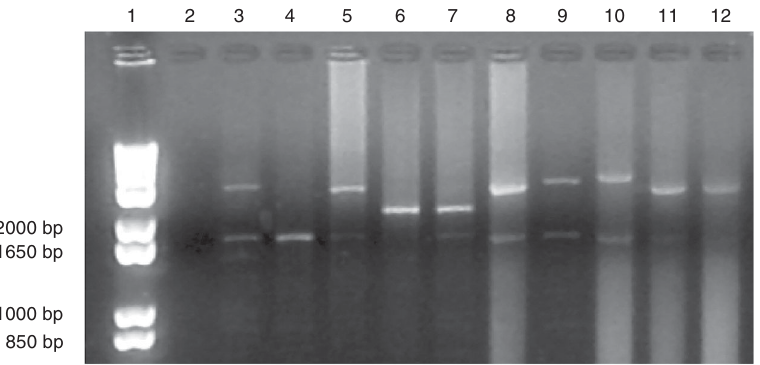
Figure 1. Amplified MUC-1 polymorphic fragments on 1.2% agarose gel. Lane 1 , 1-kb DNA ladder; lane 2 , negative control; lanes 3-7 , control patients; lanes 8-12 , infertile